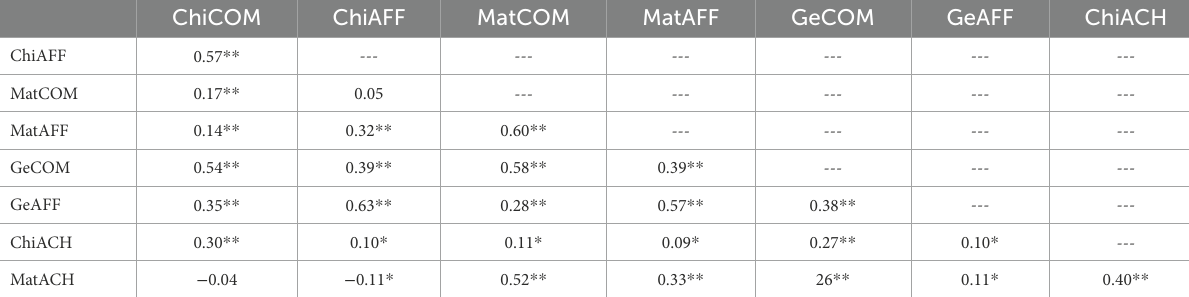
TABLE 4 Factor correlations at